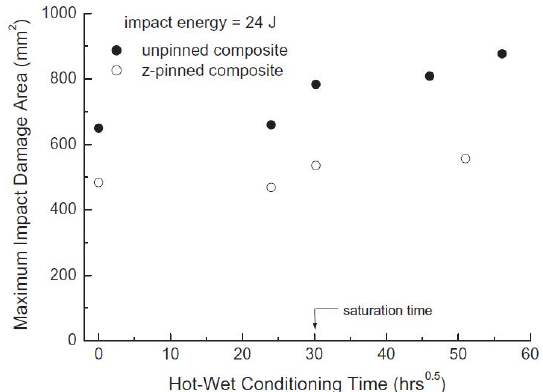
Figure 71. Effect of hot-wet conditioning (70 °C and 85% humid) on high-energy impact damage induced on z-Pinned composite (CFRP z-Pins, 2.0 vol%, d = 0.28 mm, [0/90] pre-preg, t = 4.3 mm) [24].